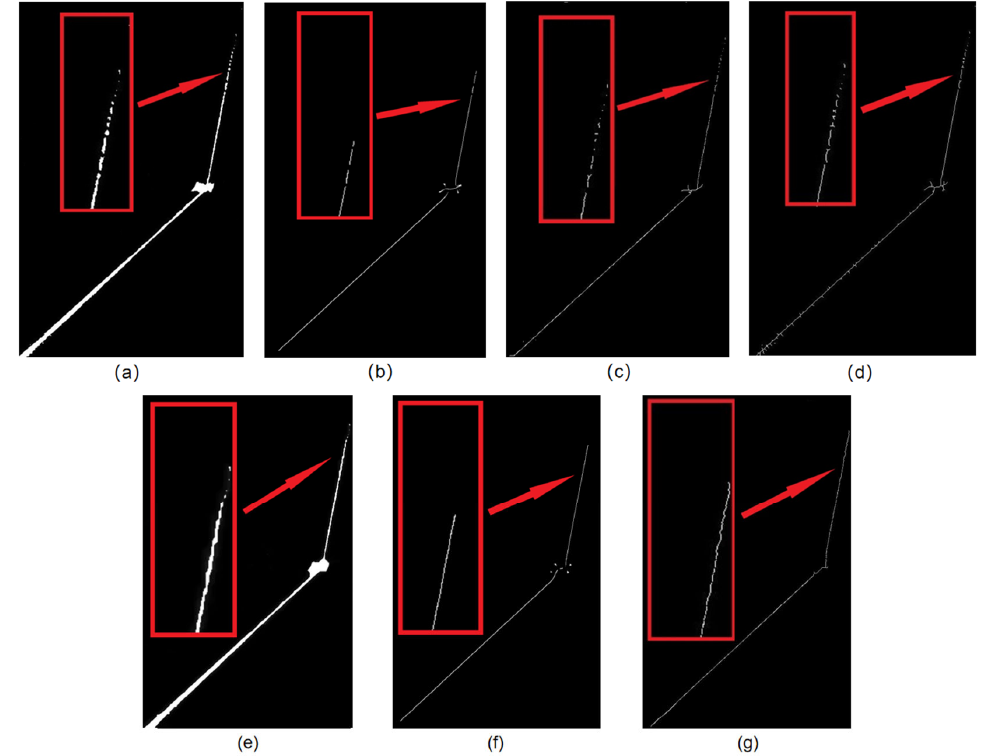
Figure 9. ( a ) Original figure; ( b ) with the Steger algorithm; ( c ) with the Zhang–Suen algorithm; ( d ) morphological corrosion results; ( e ) the closing operation; ( f ) the closing operation, combined with the Steger algorithm; ( g ) dilation, combined with the Zhang–Suen algorithm.